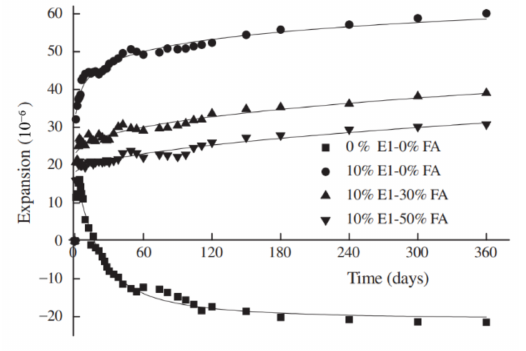
Figure 6. The influence of fly ash content on the autogenous deformation of concrete with MgO (reprinted with permission from Ref. [58], 2013,